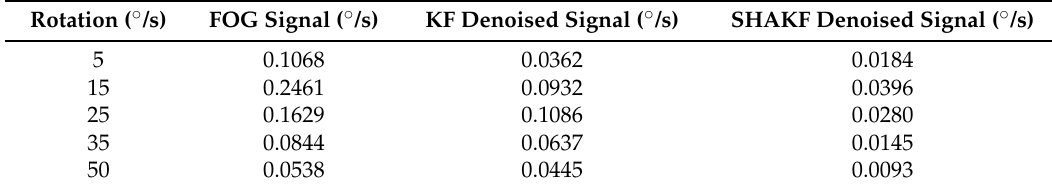
Table 2. MSE results of the FOG signal with different rotational